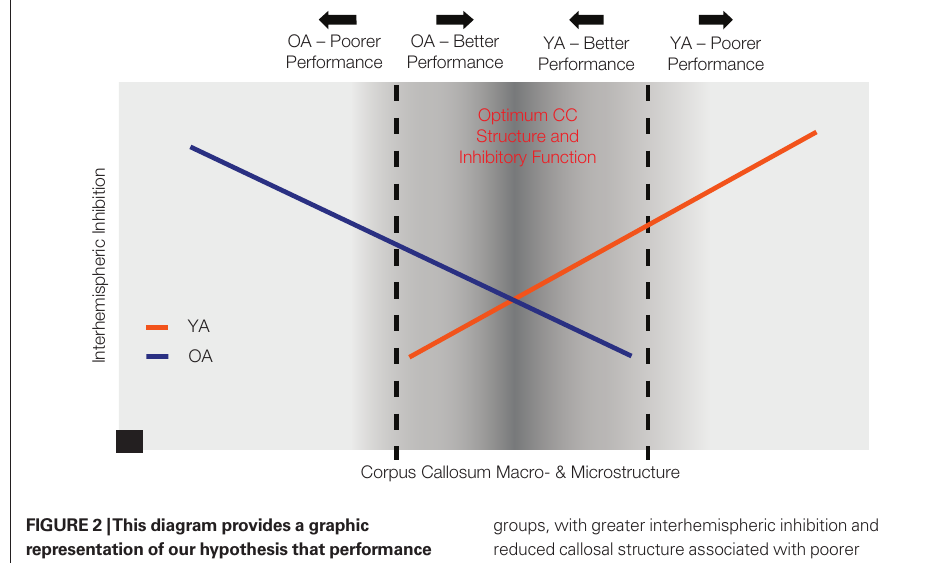
Figure 2 | This diagram provides a graphic representation of our hypothesis that performance on bimanual tasks falls along a continuum which demonstrates a shared optimal region of callosal microstructure and interhemispheric inhibition for young and older adults (darker gray central zone). Structure-physiological function-performance relationships differentially diverge from this range for the two age